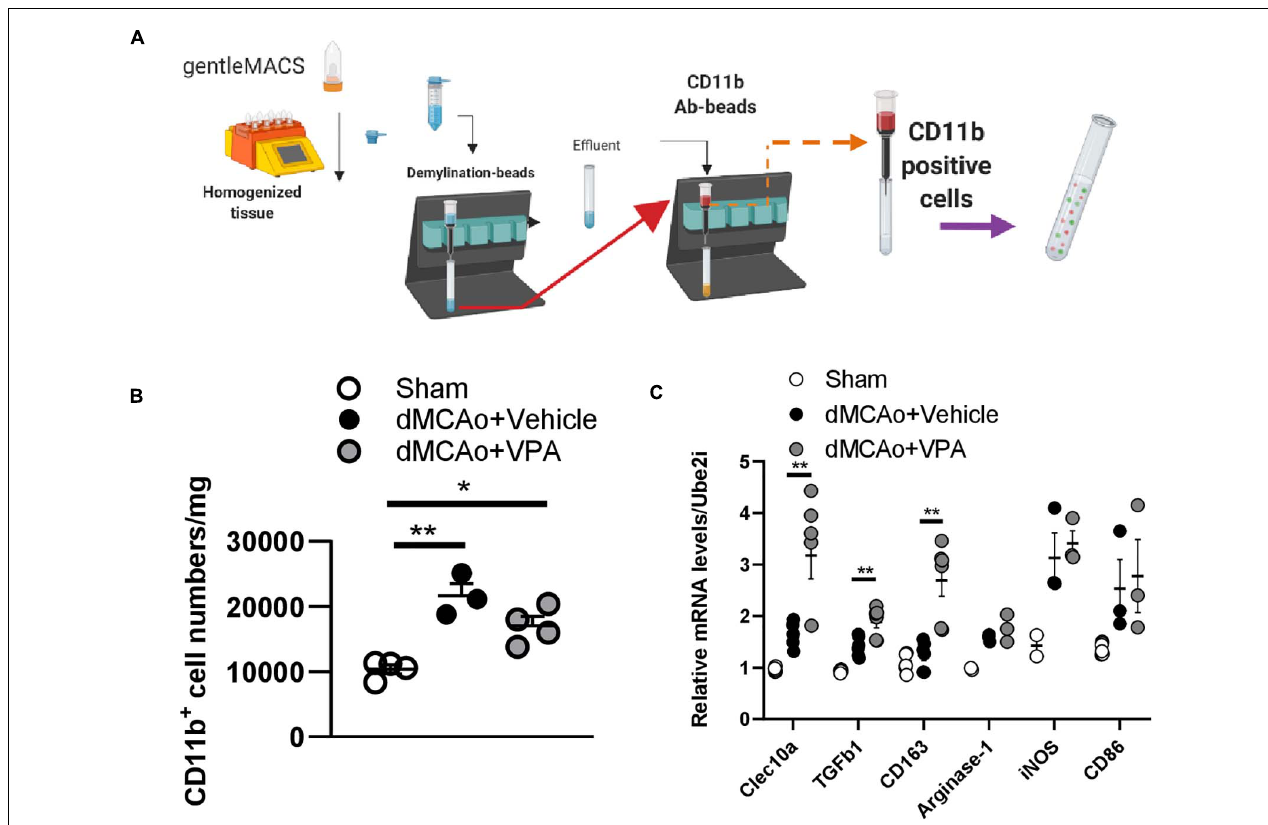
FIGURE 8 | Post-stroke VPA treatment enhances gene expressions of the alternative activated M2 phenotypes. (A) Male rats (12 weeks old) were subjected to sham operation or dMCAo surgery with/without VPA treatment. Microglia/macrophages were purified from sham cortex and peri-infarct cortex at day 3 post-dMCAo using gentleMACs Dissociator and CD11b antibody-beads. (B) There were significant differences in the number of CD11b-expressing microglia/macrophages between the sham group and dMCAo groups. (C) qPCR analysis of gene expression of alternative activated M2 phenotype ( Clec10a , TGF β 1, CD163, and Arginase-1 ) and classical activated M1 phenotype ( iNOS and CD86 ) in the CD11b-expressing microglia/macrophages of sham-operated, dMCAo + vehicle, and dMCAo + VPA groups. * P < 0.05, ** P < 0.01, Student’s t -test. N = 3–4 per group. The data represent mean ±